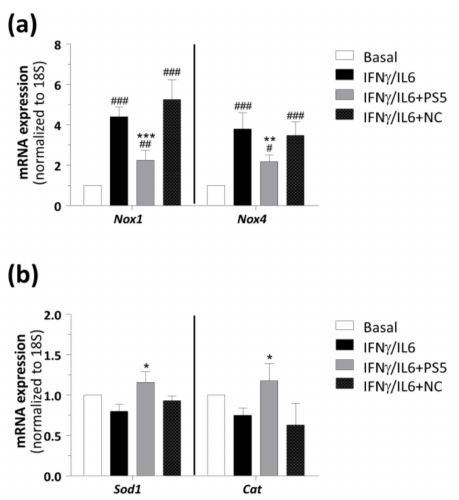
Figure 3. Real-time PCR analysis of STAT-dependent redox genes in VSMCs. The mRNA expression levels of ( a ) pro-oxidant ( Nox1 and Nox4 ) and ( b ) antioxidant ( Sod1 and Cat ) enzymes were normalized to 18S and expressed as fold increases under basal condition. Results are presented as the mean ± SEM of n = 4–5 experiments ( # p < 0.05, ## p < 0.01 and ### p < 0.001 vs. basal; * p < 0.05, ** p < 0.01 and *** p < 0.001 vs. cytokines).